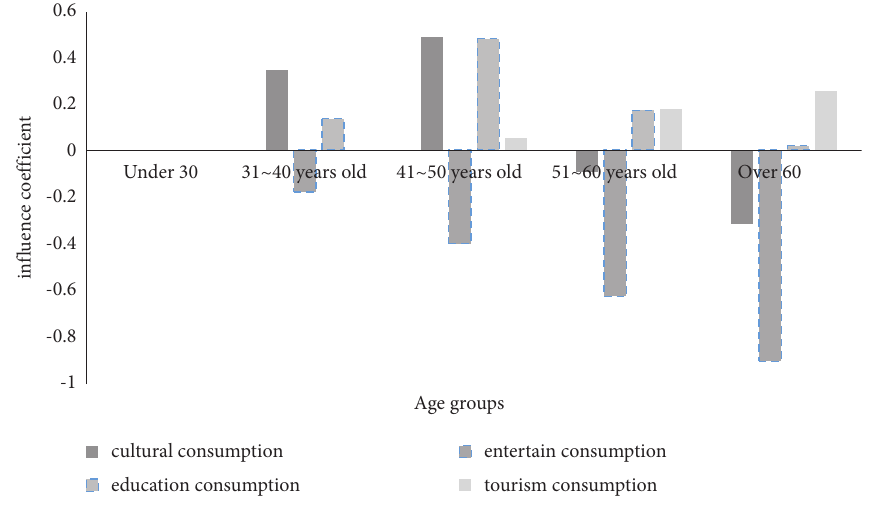
Figure 3: Impact of age groups on cultural